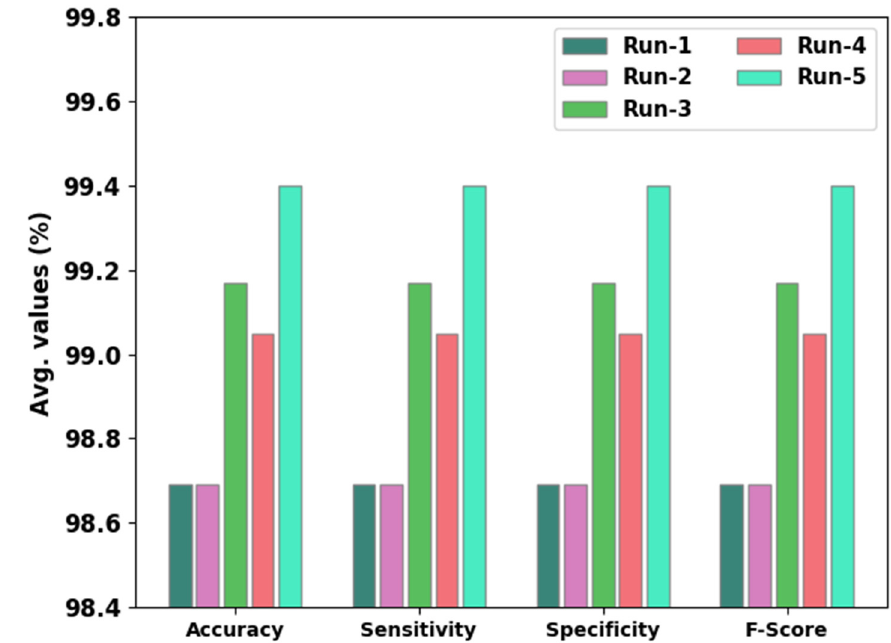
Figure 4. Average analysis of DWOML-RWD approach with distinct measures.